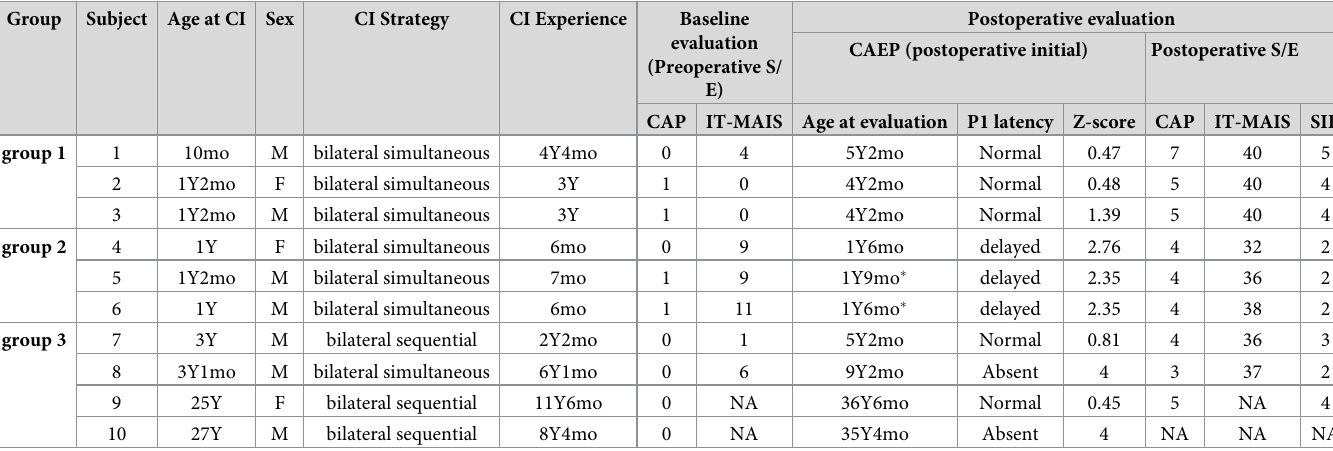
Table 1. Demographics and clinical characteristics of 10 subjects with